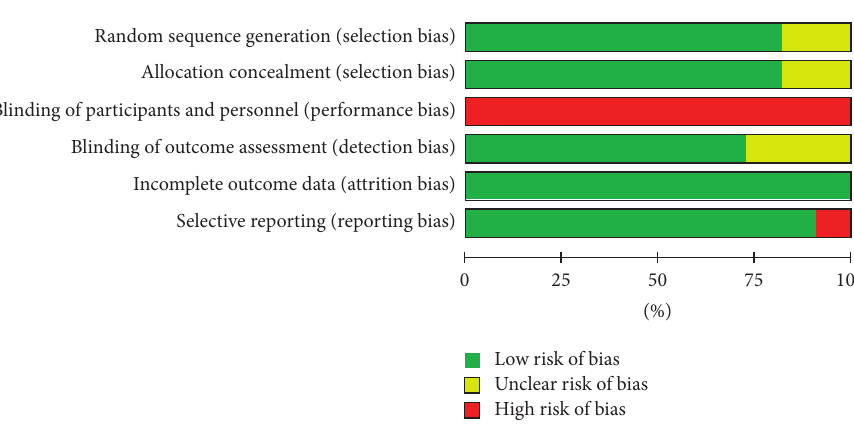
Figure 1: PRISMA flow diagram.